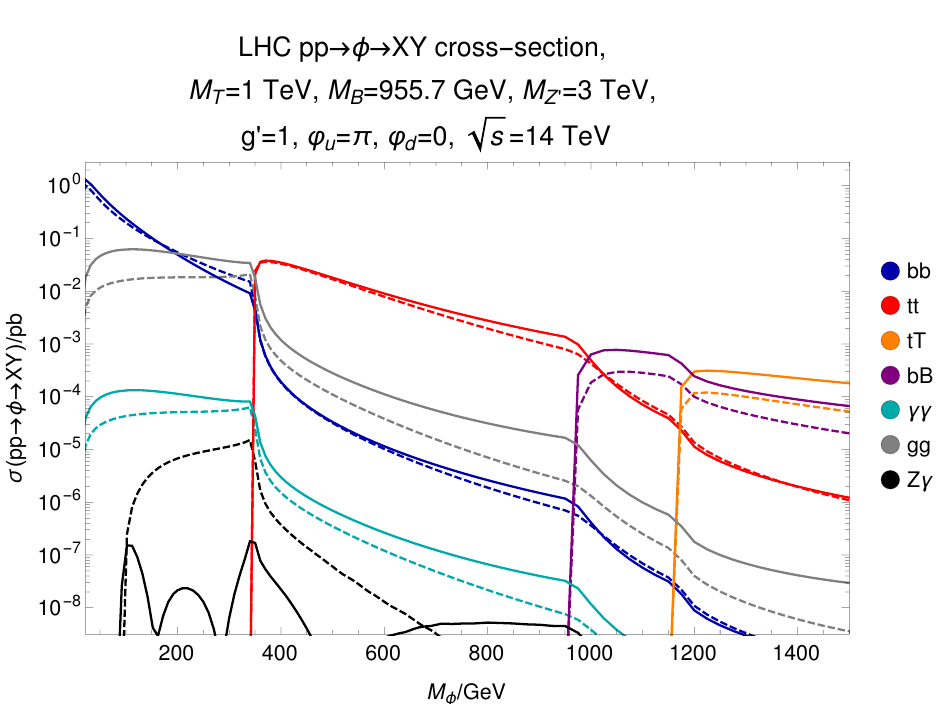
√ Figure 7. Rates for Higgs singlet Yukon φ production and decay at the LHC with s = 14 TeV. Solid lines correspond to θ Q = π/ 4 and dashed lines to θ Q = π/ 6 . Above 350 GeV the tt mode 34 34 dominates, suppressing the γγ signal, making the Yukon φ harder to